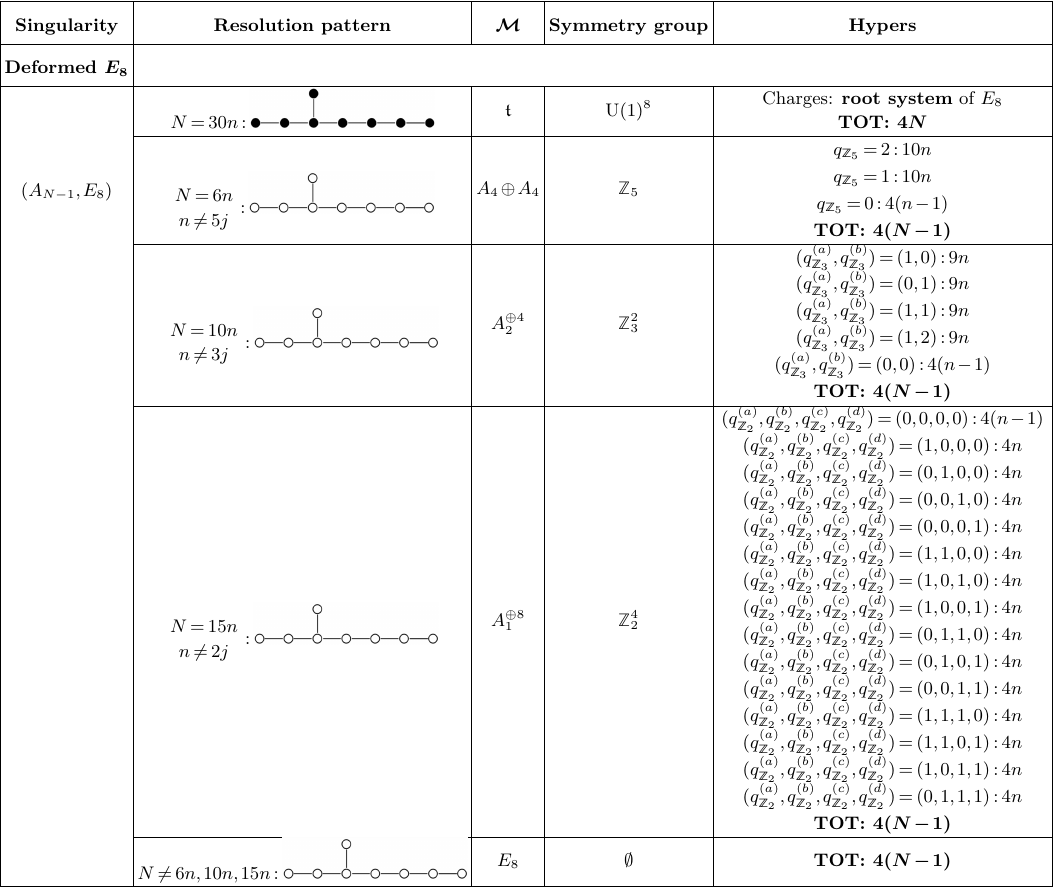
Table 8 . Higgs branch data for quasi-homogeneous cDV singularities of ( A N − 1 , E 8 )